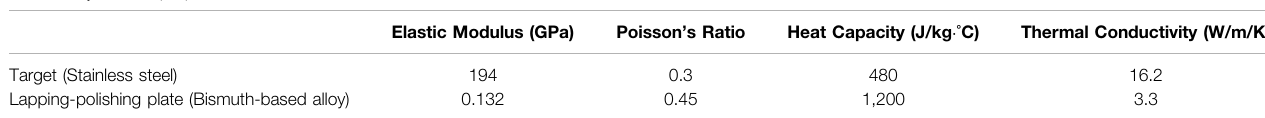
TABLE 1 | Material properties in